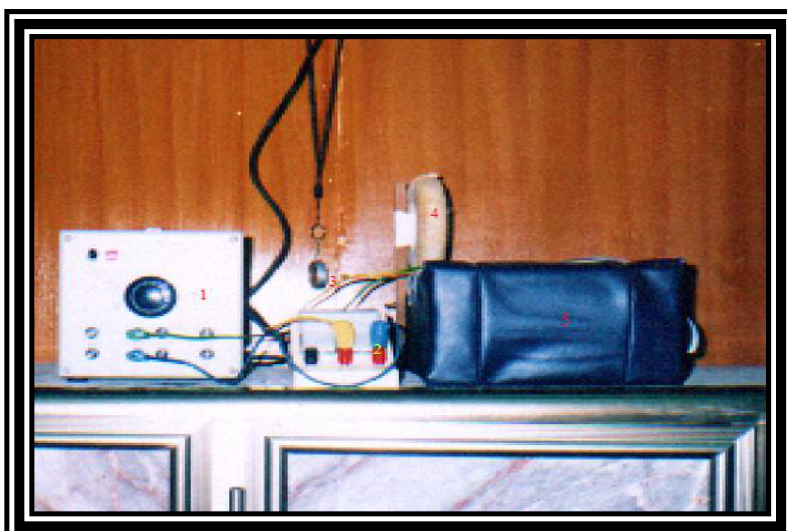
Figure(1) Magnetic apparatus(1-power supply2-ammter, 3-compass,4-magnetic